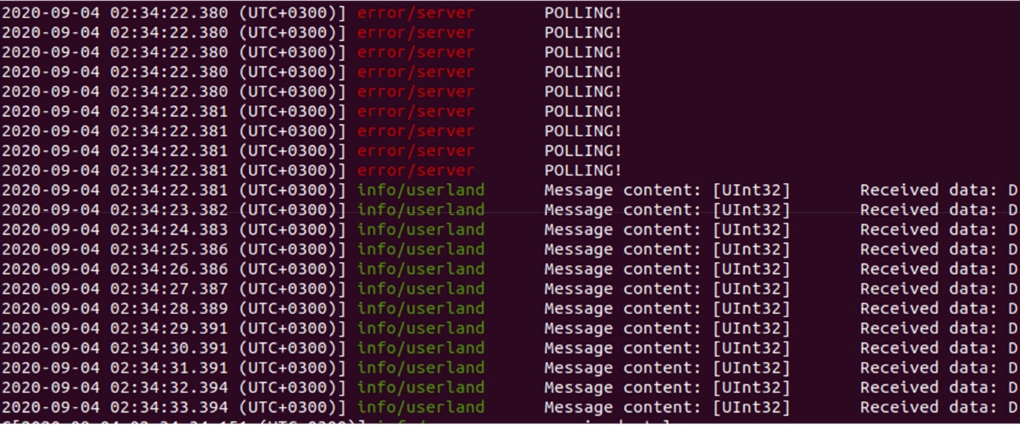
Figure 9. Terminal of Subscriber2 receiving the desired data at time intervals of 1